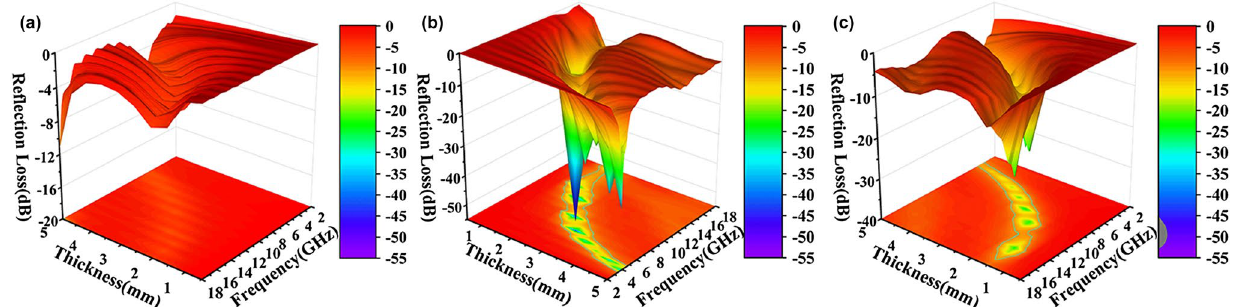
Fig. 7 3D maps of RL values for S6 ( a ), S7 ( b ), and S8 ( c ) at different thicknesses over 2–18 GHz